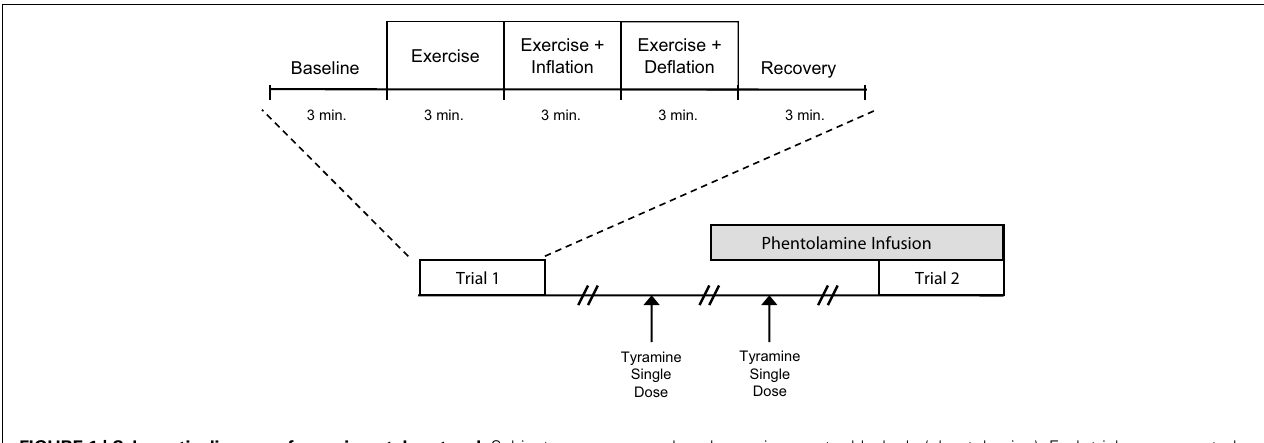
FIGURE 1 | Schematic diagram of experimental protocol. Subjects completed two trials. Each trial consisted of baseline, exercise (control), exercise during inflation, exercise following deflation, and recovery measurements (3min each).Trials were performed during control (no drug)